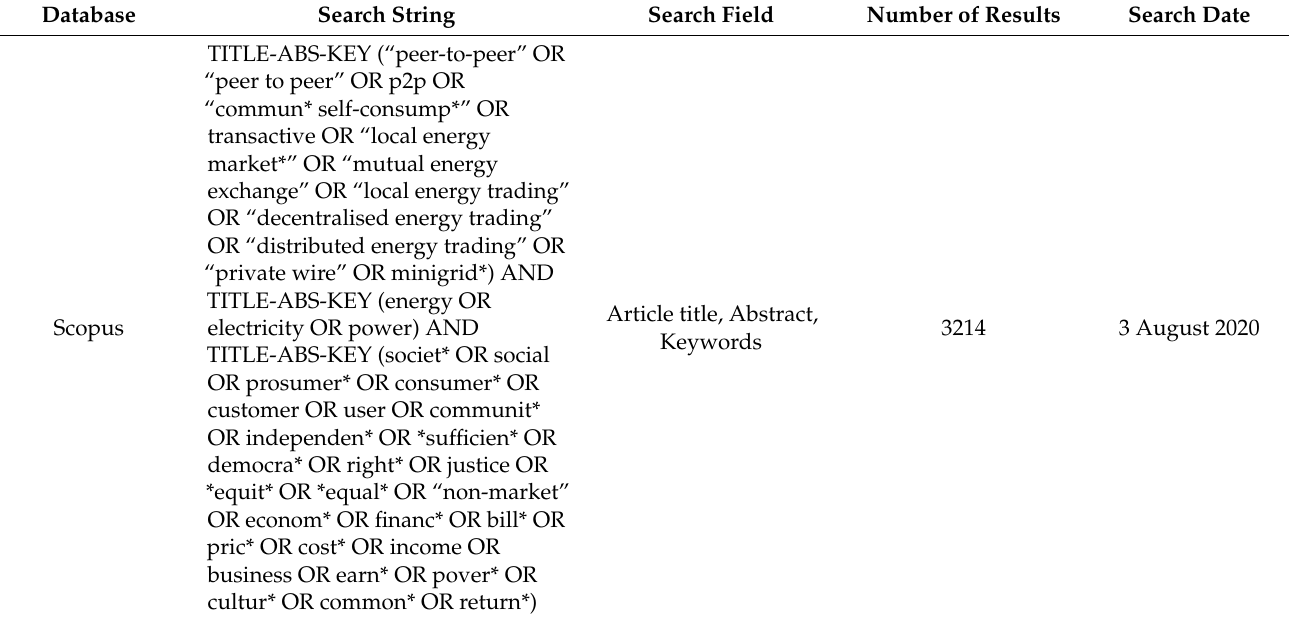
Table A1. The searches that were run to identify the results included in the review